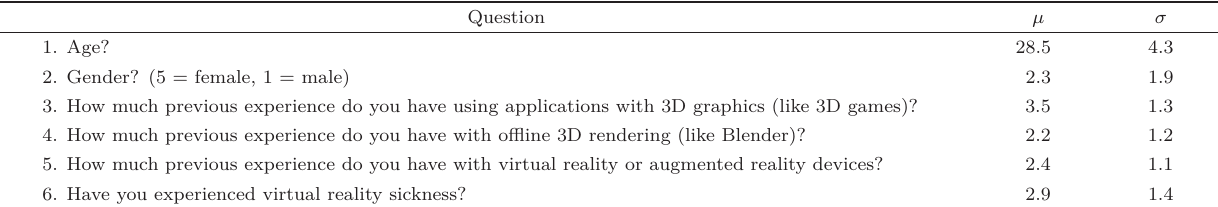
Table 1 Arithmetic mean ( μ ) and standard deviation ( σ ) of answers to the background